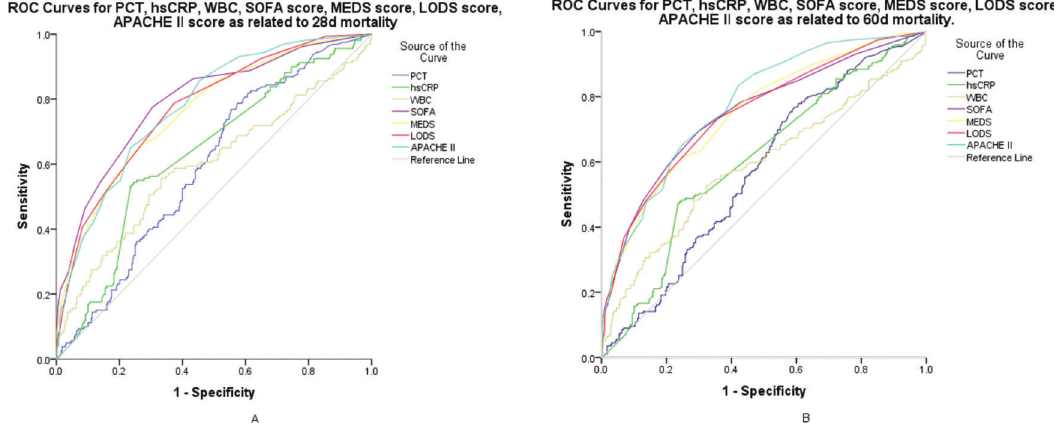
Figure 2 - ROC curves for the prognosis of early (A) and late (B) mortality among patients with sepsis and septic shock. A: AUC demonstrates that serum PCT measures 0.634 (95% CI, 0.586–0.682), hs-CRP measures 0.640 (95% CI, 0.587–0.692), WBC measures 0.595 (95% CI, 0.536–0.654), SOFA score measures 0.805 (95% CI, 0.763–0.847), MEDS score measures 0.761 (95% CI, 0.715–0.807), LODS score measures 0.785 (95% CI, 0.742–0.827), and APACHE II score measures 0.778 (95% CI, 0.736–0.821) for the prognosis of early mortality. B: AUC demonstrates that serum PCT measures 0.596 (95% CI, 0.548–0.645), hs-CRP measures 0.605 (95% CI, 0.555–0.656), WBC measures 0.586 (95% CI, 0.532–0.640), SOFA score measures 0.754 (95% CI, 0.709–0.799), MEDS score measures 0.744 (95% CI, 0.699–0.788), LODS score measures 0.755 (95% CI, 0.711–0.799), and APACHE-II score measures 0.774 (95% CI, 0.734–0.815) for prognosis of late mortality. ROC, receiver operating characteristic; AUC, area under the curve; PCT, procalcitonin; CI, confidence interval; hs-CRP, high sensitivity C-reactive protein; WBC, white blood cell; SOFA, Sequential organ failure assessment; LODS, Logistic organ dysfunction system; MEDS, Mortality in emergency department sepsis; APACHE-II, Acute Physiology and Chronic Health Evaluation II.